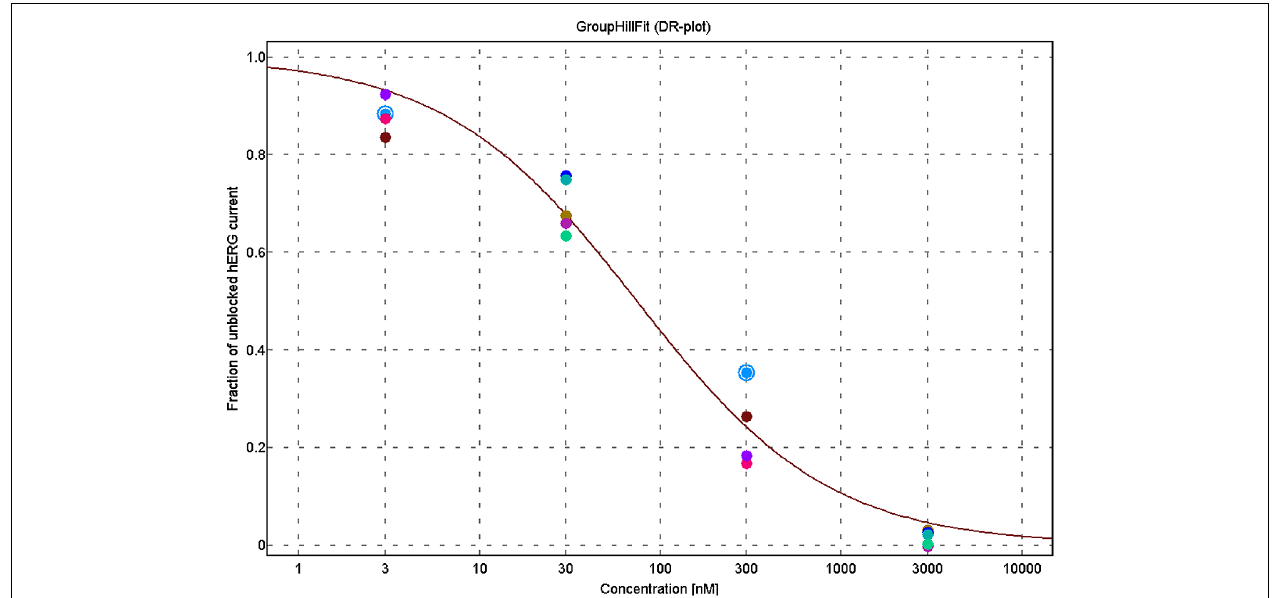
value which was recorded at the end of the saline period before the first compound application. The combined data of all nine cells was then fitted to the hill equation y = c h /(IC 50h + c h ) to estimate the half maximal inhibition concentration (IC 50 value) and hill coefficient h for this compound (IC 50 = 72 nM, h = 0.8).